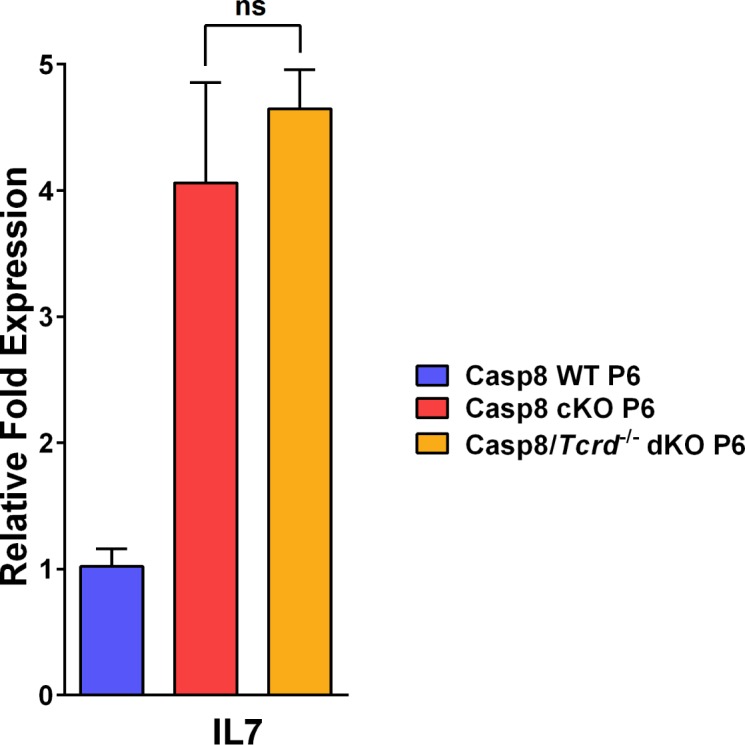
IL-7 expression in a mouse model of wound healing as revealed by qPCR measurements of levels of IL-7 expression by keratinocytes.Data are the fold difference ± SEM of three samples per genotype analyzed in triplicate. The levels of IL-7 in the caspase-8 cKO and the caspase-8 cKO/γδT-cell KO at postnatal day six skin are not statistically different (ns).